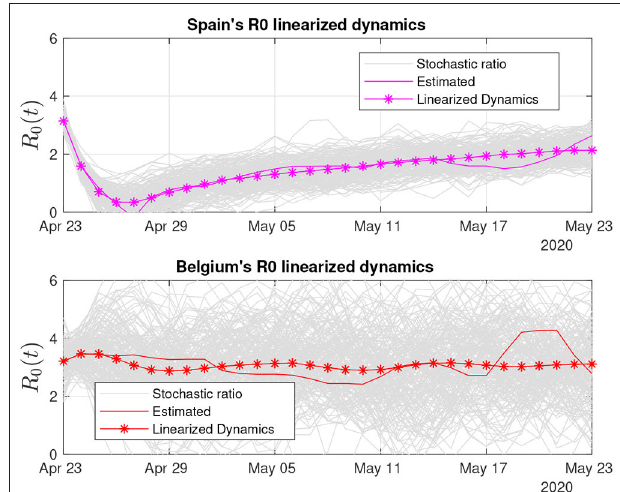
FIGURE 10 | Thirty days of linearized R 0 dynamics for Spain and Belgium. Both countries exhibit high variability of the stochastic ratio, which is suggestive of problems with either data compilation or difficulties to stabilize the pandemic.